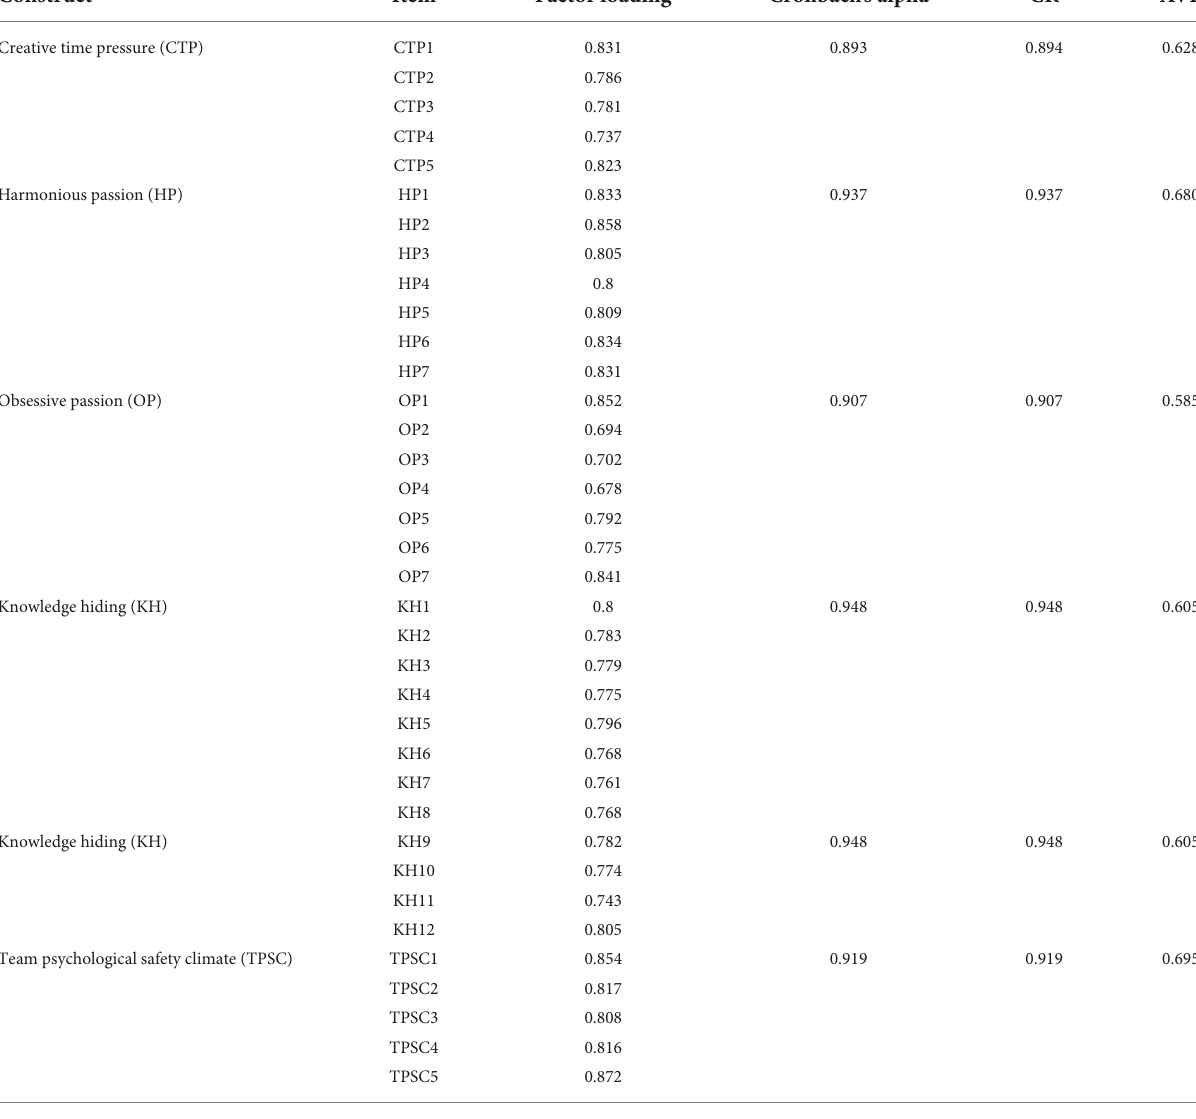
TABLE 1 Indices for construct reliability and convergent validity.